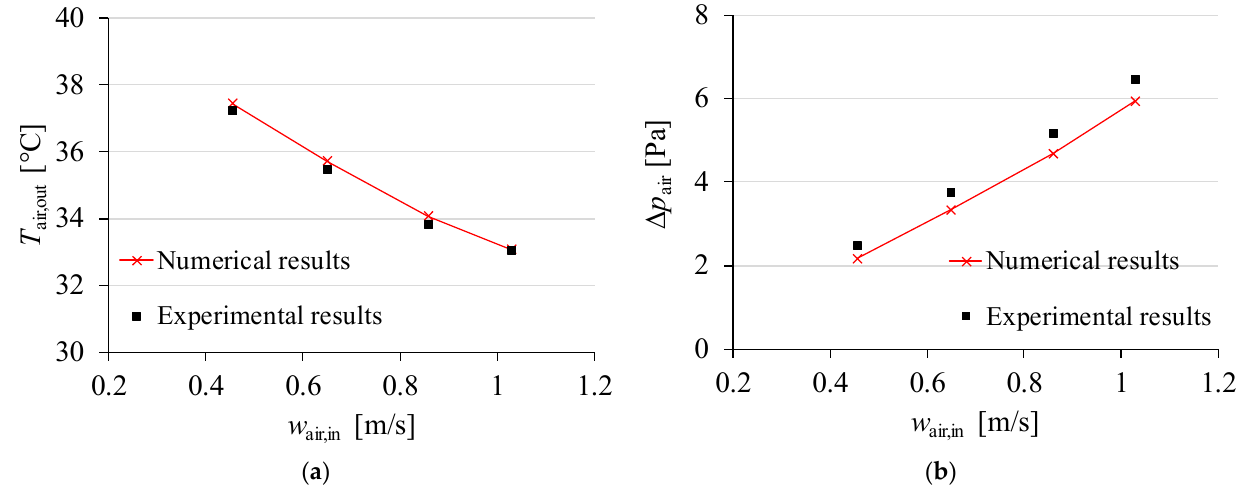
Figure 10. Comparison between experimentally and numerically obtained results on plain air-to- water FTHEX for ( a ) average air outlet temperatures, ( b ) air-side pressure drops. Test conditions: T air,in = 22 °C, T water,in = 40 °C, w water,in = 0.76 m/s.